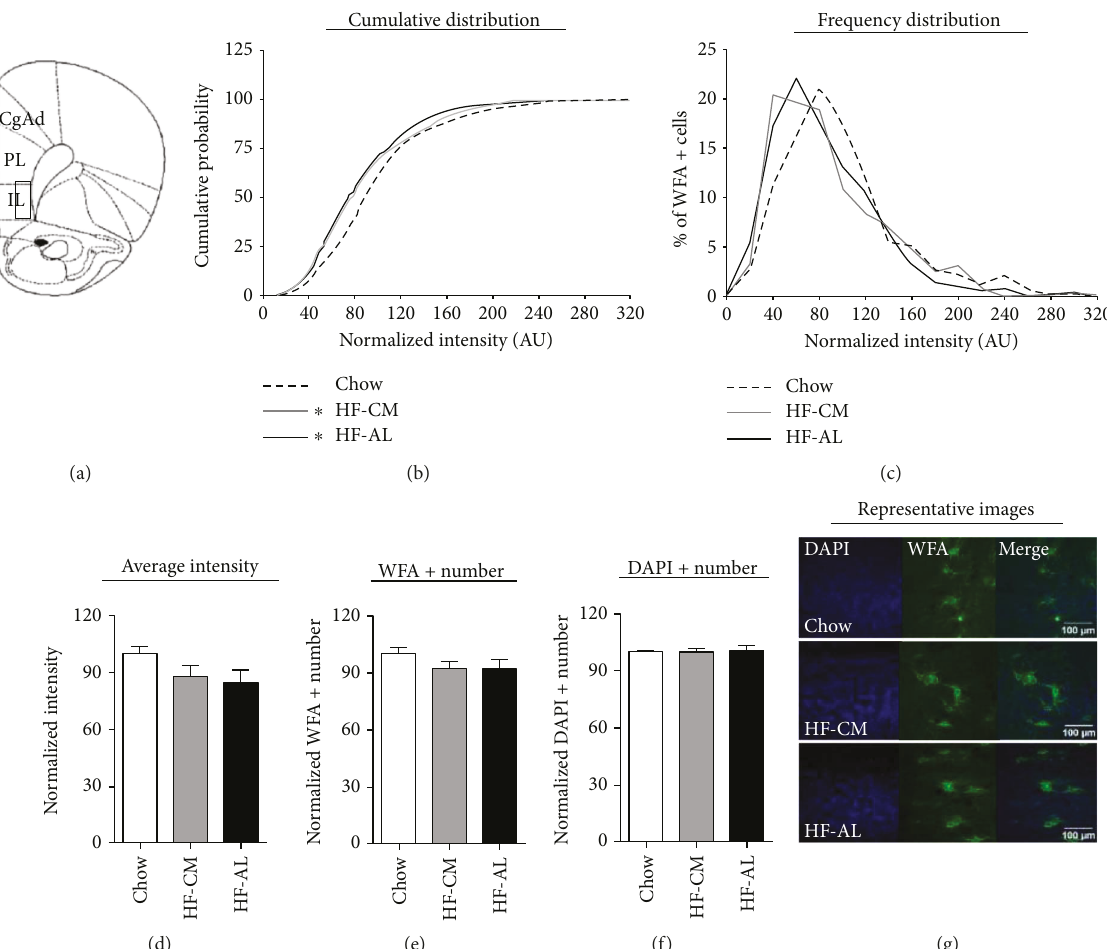
Figure 3: Consumption of a high-fat diet does not alter PNN intensity nor PNN number in the infralimbic prefrontal cortex (IL-PFC). (a) Schematic of the region analyzed. (b) Normalized PNN intensity expressed as a cumulative probability for chow (dashed line), HF-CM (gray line), and HF-AL (black line) groups. (c) Normalized PNN intensity expressed as a frequency distribution for chow, HF-CM, and HF-AL groups. (d) Normalized average PNN intensity among chow (white), HF-CM (gray), and HF-AL (black) groups. (e) PNN number, measured by the number of WFA+ cells. (f) Cell density, measured by the number of DAPI+ cells. (g) Representative images shown as max projections of z-stacks. Values represent the mean ± SEM ( ∗ p < 0 05 ). ∗ indicates signi fi cant di ff erence between HF-CM and chow as well as between HF-AL and